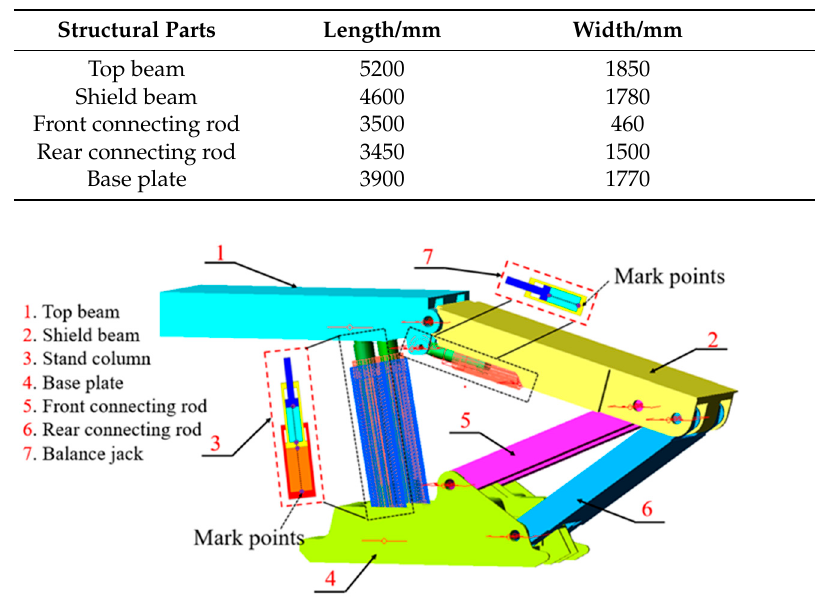
Figure 1. Mechanical system model.